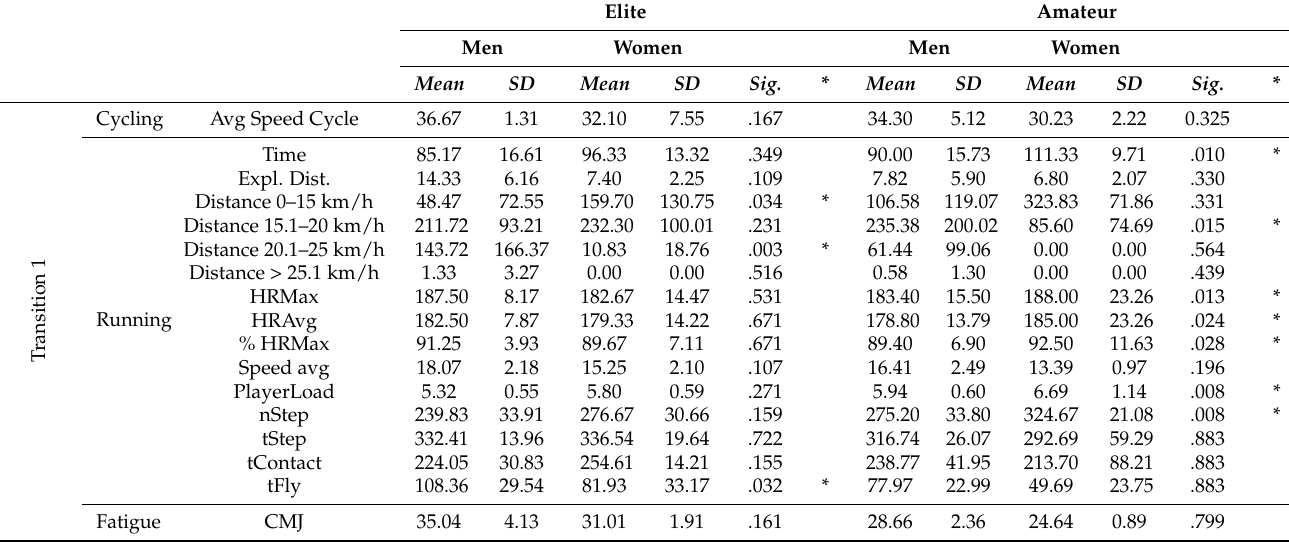
Table 2. Descriptive and inferential results of the variables analyzed based on the circuit transition without